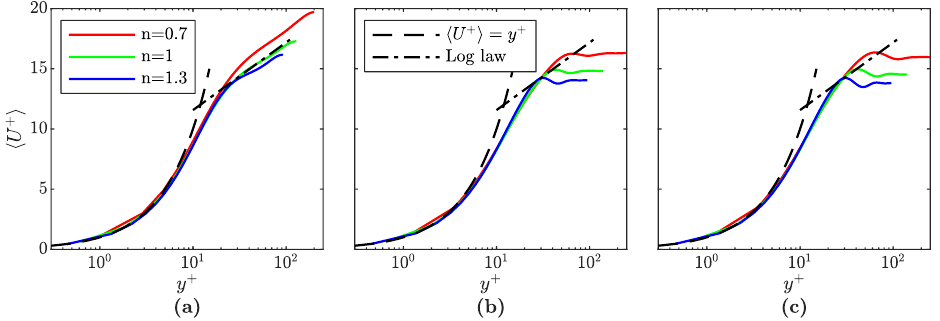
Figure 8. Semilogarithmic plot of the average stream-wise velocity, normalized by the actual friction velocity to yield (cid:104) U + (cid:105) , as a function of the dimensionless distance from the wall for the single-phase ( a ) and the two-phase setups with Eo = 0.3125 ( b ) and Eo = 3.75 ( c